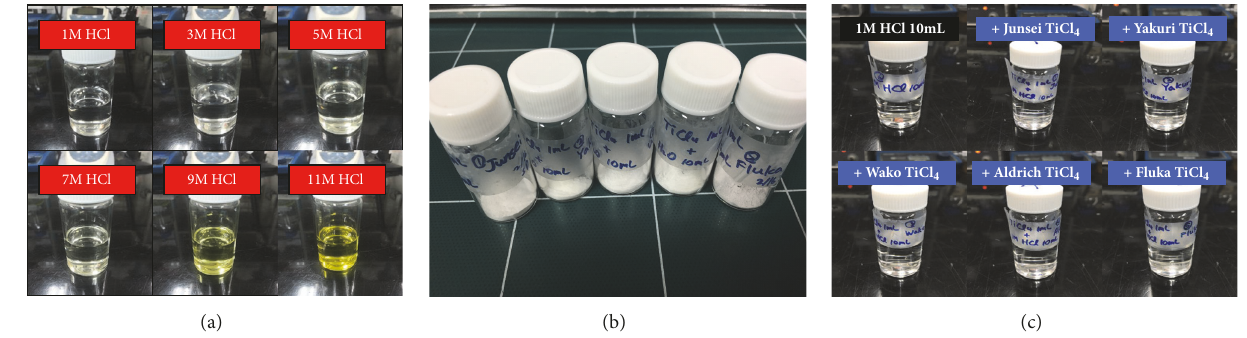
Figure 1: Stabilized titanium tetrachloride samples; (a) in various concentrated hydrochloric acid solutions, (b) hydrolyzed and calcined titanium tetrachloride (titanium oxide), and (c) titanium chloride samples and diluents prepared for ICP-OES